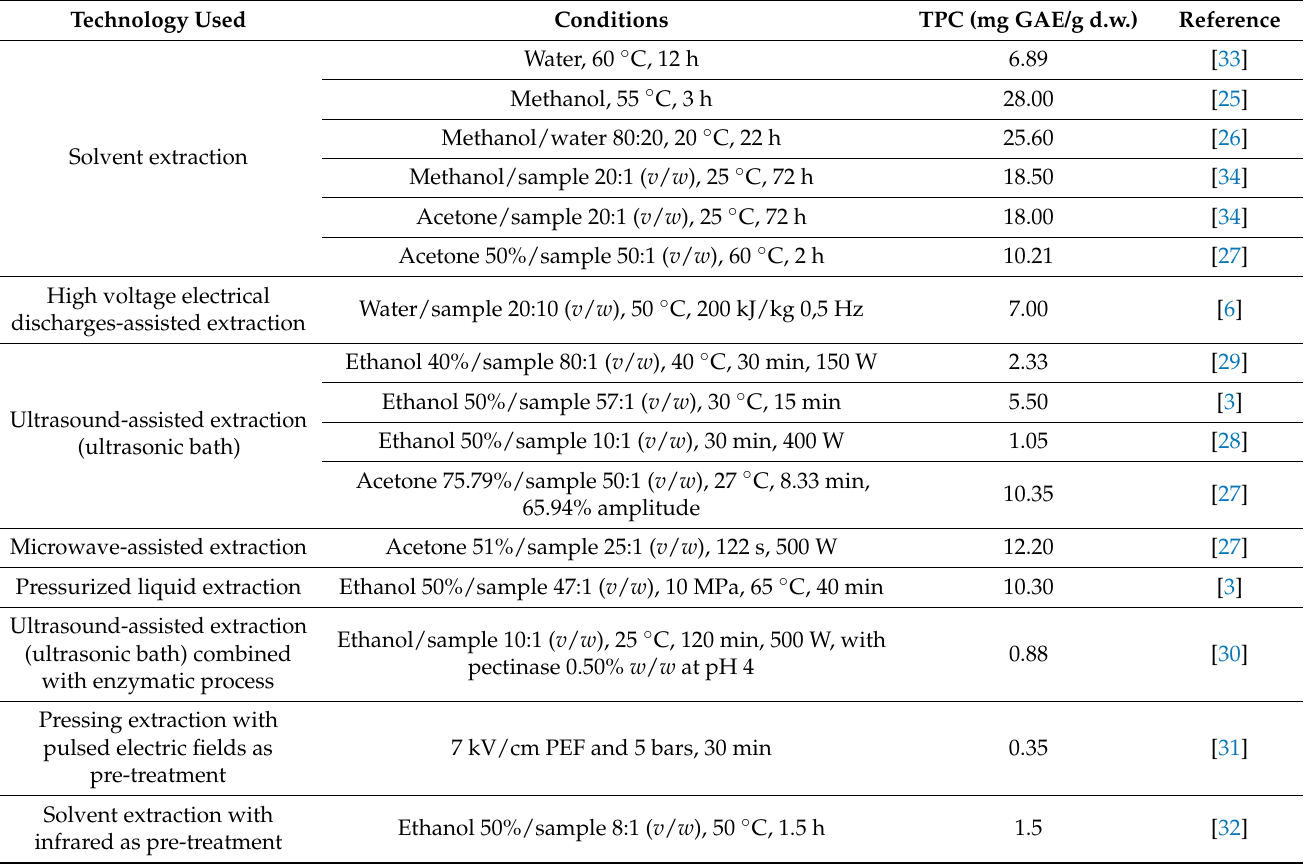
Table 4. Previous research about other technologies used for extracting phenolic compounds from the orange by-products with the conditions used and the total phenolic compounds (TPC) obtained.